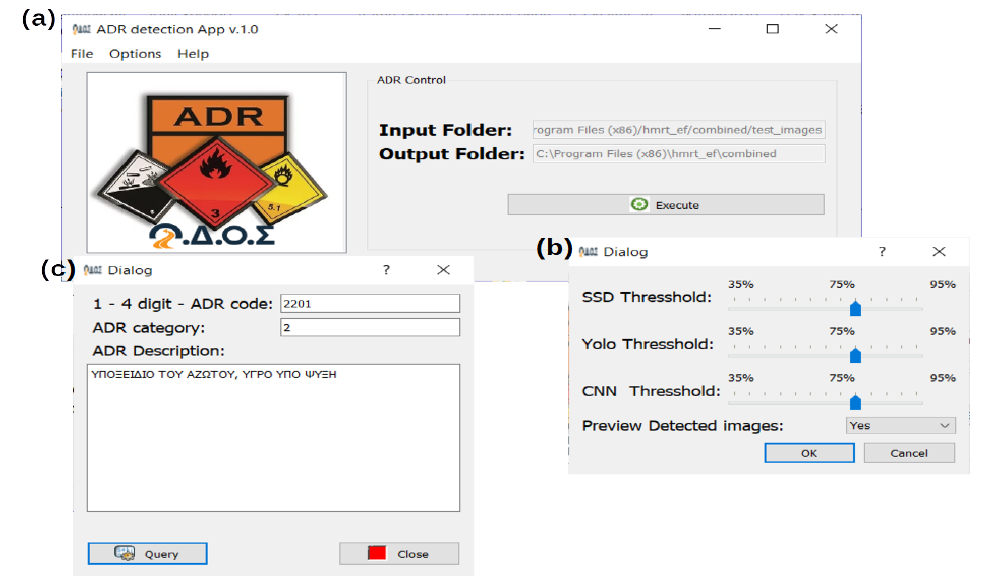
Figure 2. HMRT-EF application and dialogs. ( a ) Main window form, ( b ) Settings dialog, and ( c ) ADR SQLite query dialog.